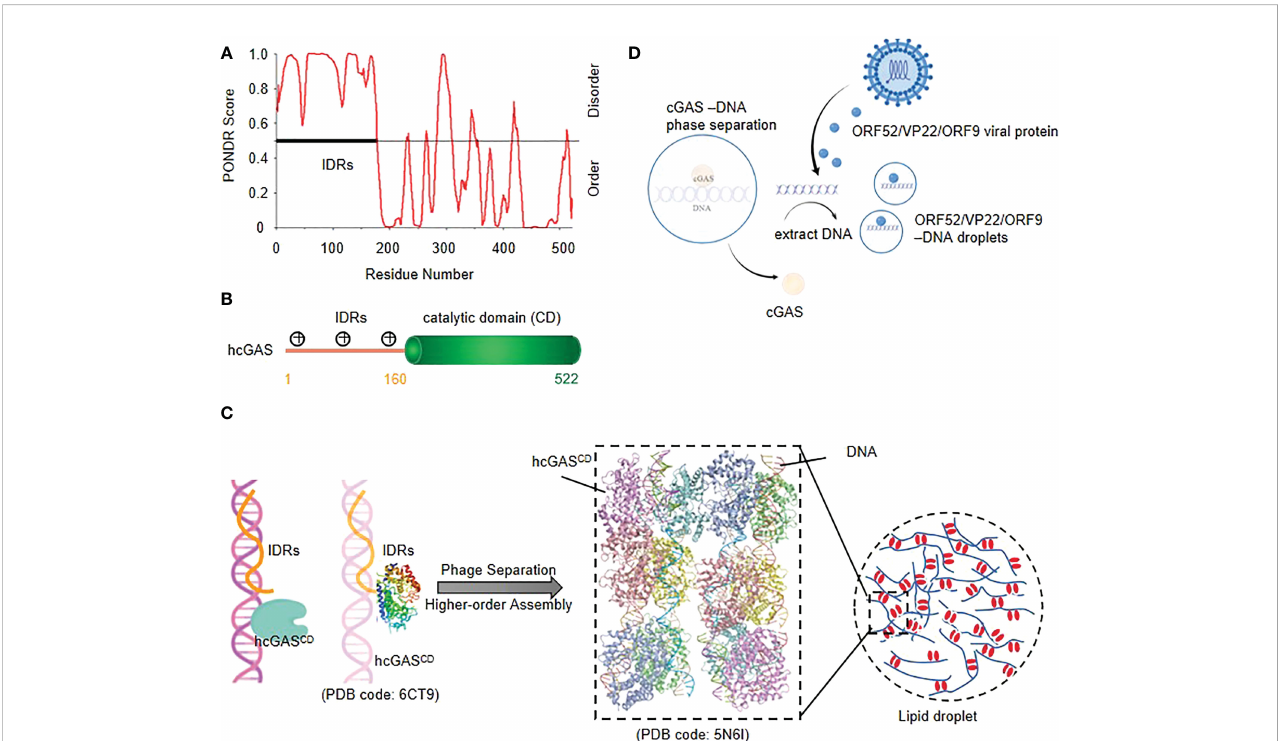
FIGURE 1 cGAS-DNA phase separation enhances innate immune responses to cytosolic DNA (A) Structural prediction of cGAS using PONDR (B) Schematic of the domain structure of human cGAS. (C) Model of cGAS-DNA phase separation. The IDRs of Nterminal cGAS nonspeci fi cally bind with DNA, and then a robust cGAS-DNA phase separation and higher-order assembly are induced. (D) viral proteins restrict cGAS-DNA condensates in vitro and in cells; ORF52/VP22 virus can disrupt the cGAS-DNA condensates through extracting the DNA to form new droplets with DNA in order to evade immune